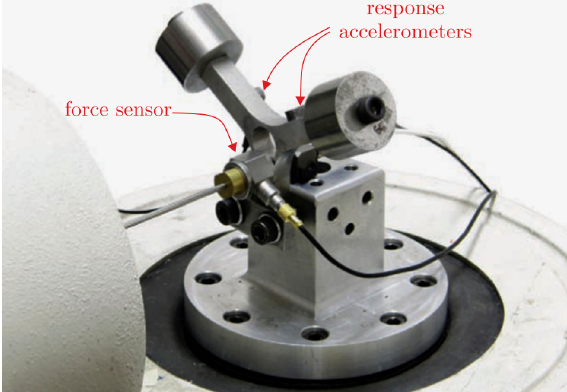
Figure 10. Testing system including Y-shaped specimen with a central hole and two masses at the free ends subjected to horizontal force and vertical acceleration (reprinted with permission from ref. [23]. Copyright 2016 Elsevier).